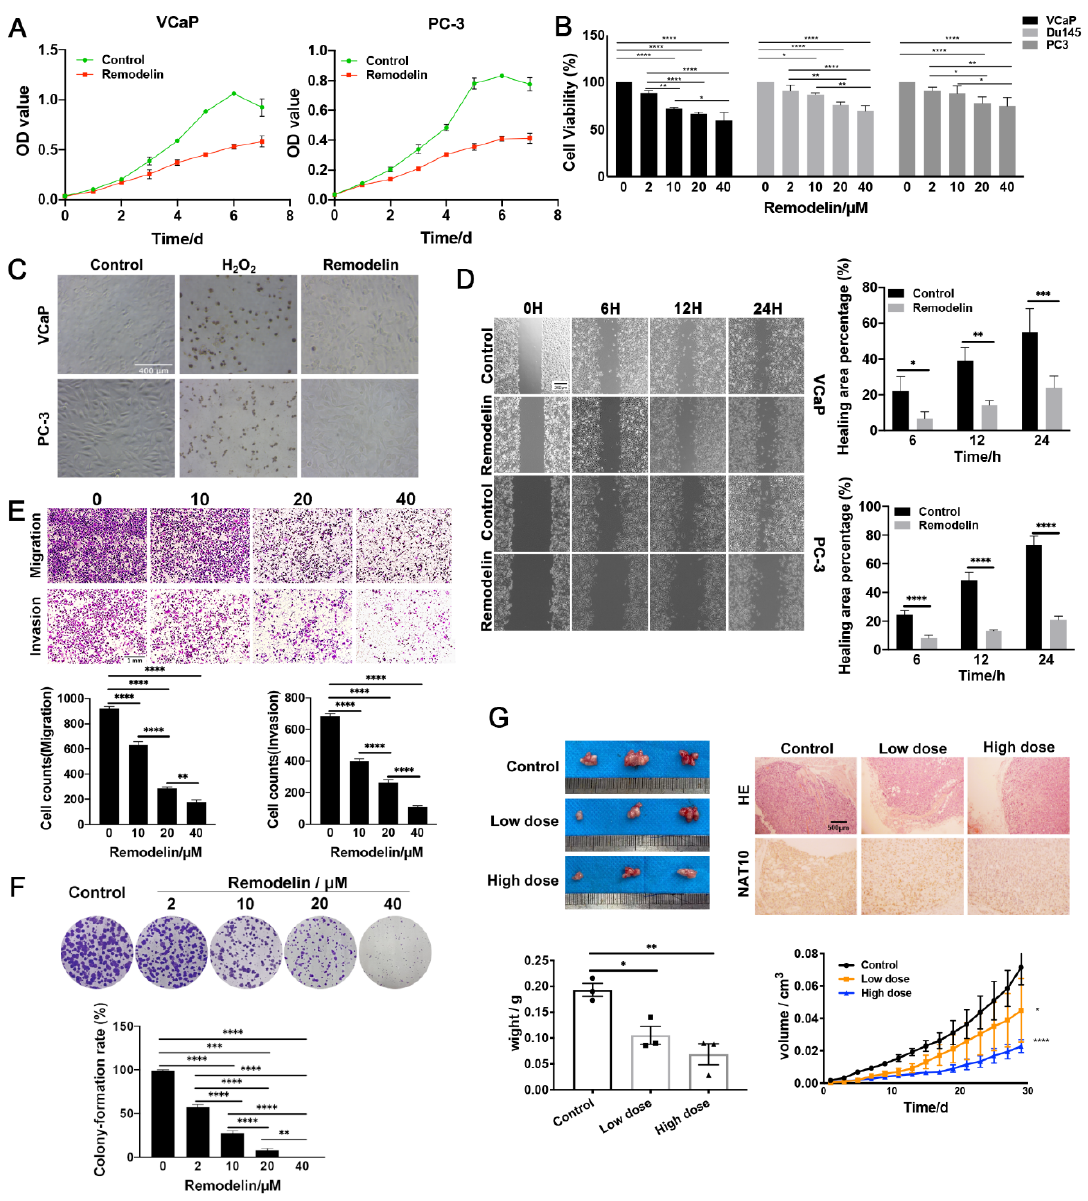
Figure 1. Inhibition of NAT10 suppresses the growth of both AR-positive and AR-negative prostate cancer cells. ( A ) Inhibition of NAT10 decreased the proliferation of prostate cancer cells in vitro. PC-3 and VCaP cells were treated with DMSO or Remodelin (20 µ M), cell proliferation activity was measured every day, and a growth curve was drawn after 7 days. The experiment was repeated three times. Data are expressed as the mean ± SD. ( B ) PC-3, DU145, and VCaP cells were treated with different concentrations of Remodelin (0, 2, 10, 20, or 40 µ M) for 48 h, and proliferation was evaluated. The level of statistical significance was compared using one-way ANOVA with Tukey post-hoc test to correct for multiple testing. ( C ) The analysis of cellular apoptosis in prostate cancer cells. VCaP and PC-3 cells were treated with either 20 µ M Remodelin or 0.4 mM H 2 O 2 for 24 h, respectively, and TUNEL assay was carried out according to the manufacturer’s instructions, as described in the Materials and Methods. ( D , E ) Inhibition of NAT10 decreased the migration and invasion of prostate cancer cells in vitro. ( D ) Cultured VCaP and PC-3 cells were subjected to wound healing assays with DMSO or Remodelin (20 µ M). The level of statistical significance was compared using a t-test. p value versus control group. ( E ) VCaP cells were pretreated with different concentrations of Remodelin (0, 10, 20, or 40 µ M) for 24 h, followed by Transwell assay. Representative images in each group are shown, and the data were quantified from triplicate experiments, and are